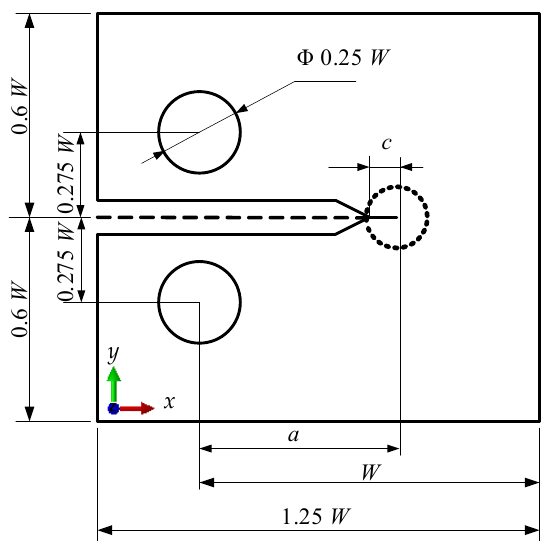
Figure 3. Geometric size of the compact tension specimen (where, W = 50 mm, a = 0.5 W, c = 1.5 mm).